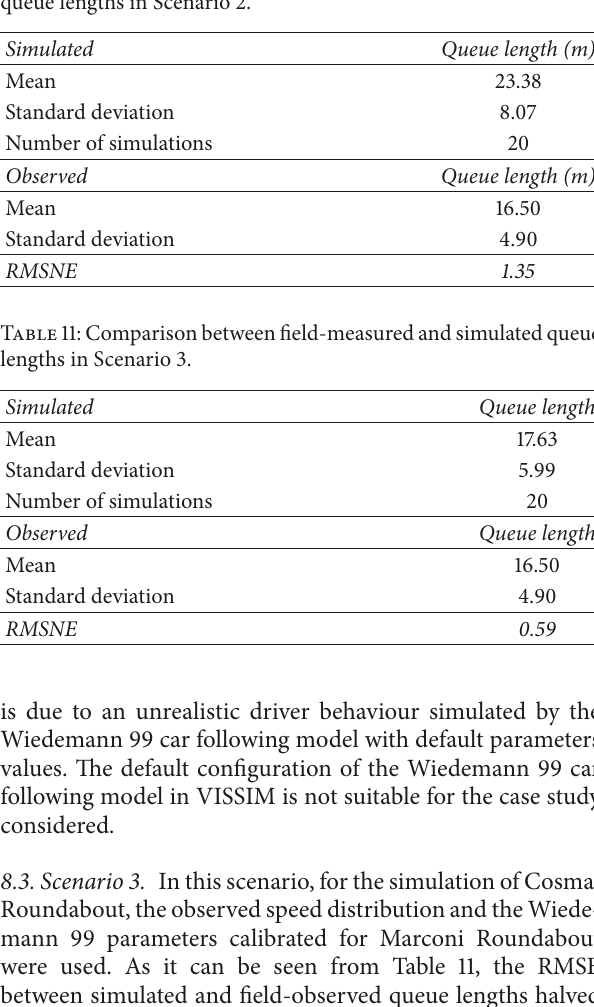
Table 10: Comparison between field-measured and simulated queue lengths in Scenario 2.